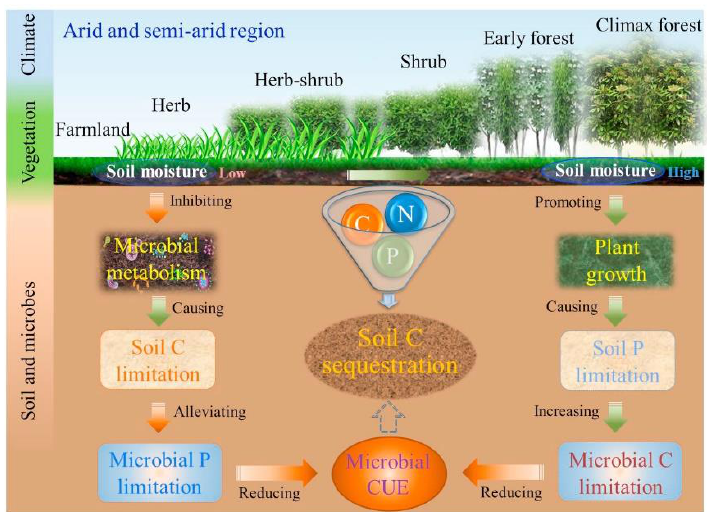
Figure 5. Conceptual diagram for the influence of soil moisture change on processes controlling soil microbial metabolism during the secondary succession. Reprinted with permission from Ref. [104].